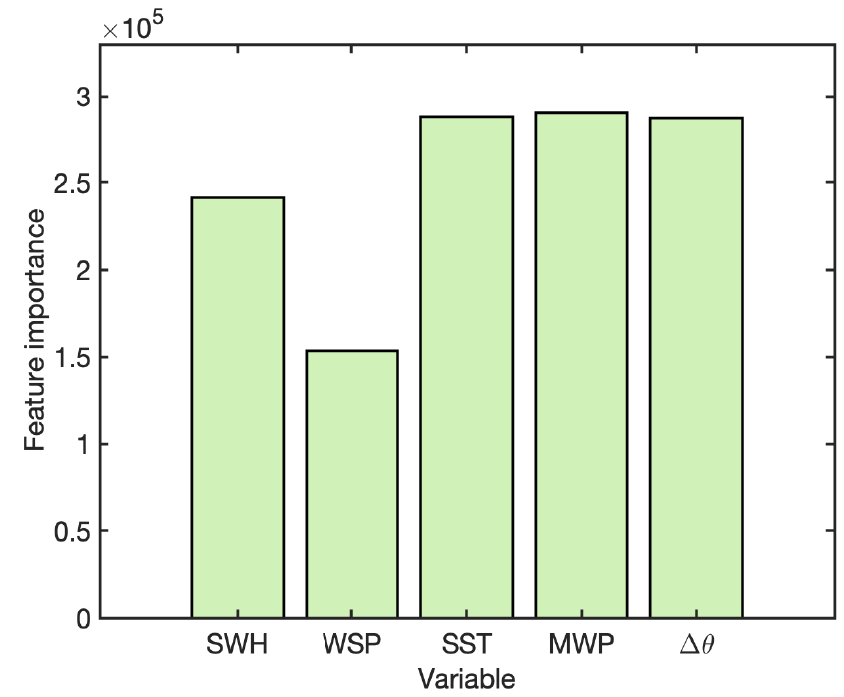
Figure 9. The feature importance for different variables in Lgb-W.